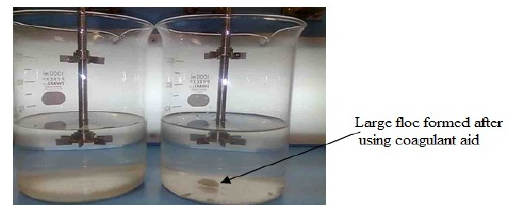
Fig.8. Effect of coagulant aid on the flocs shape and size; Left: water treated with alum alone, Right: water treated with alum + coagulant